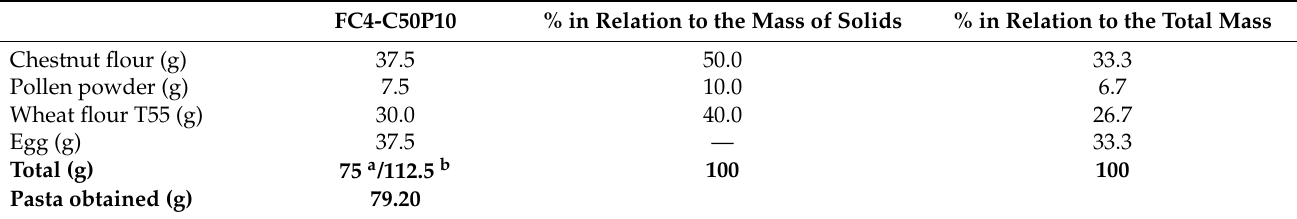
Table 4. Formulation of egg pasta with 50% chestnut flour and 10% pollen